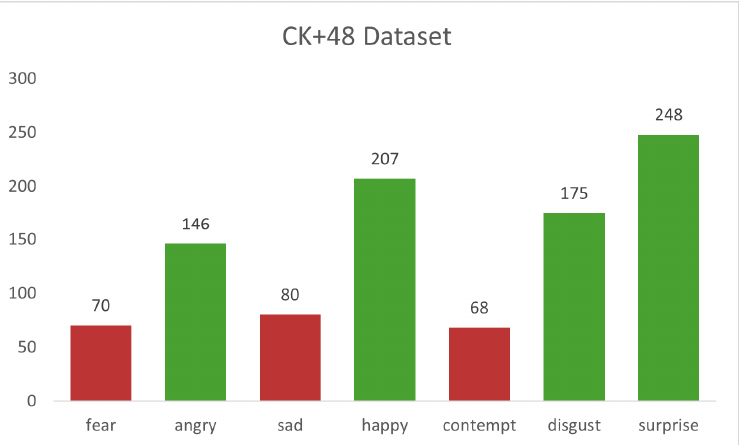
Figure 4. Distribution of the CK+48 dataset with the classification of classes describing their mean values.